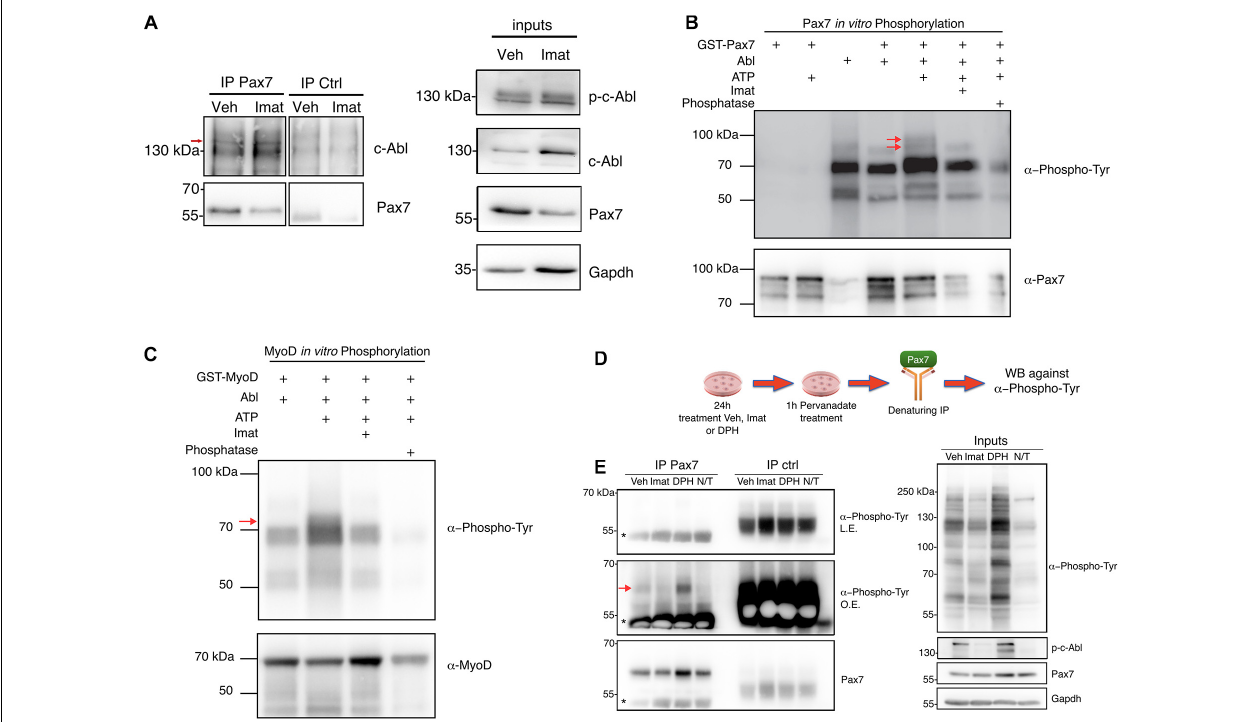
FIGURE 4 | c-Abl interacts and phosphorylates Pax7. (A) c-Abl co-immunoprecipitates with Pax7 in C2C12 cells. Cells maintained in PM were treated with vehicle (Veh) or 10 µ M Imatinib (Imat) for 24 h, followed by lysis and immunoprecipitation (IP) with anti-normal mouse IgG (IP ctrl) or anti-Pax7 (IP Pax7). c-Abl and Pax7 were detected by Western blot (Left panels). Red arrow shows the expected c-abl relative migration. Right panels show inputs for p-c-Abl, c-Abl, Pax7, and Gapdh ( n = 3). (B) Pax7 is phosphorylated by c-Abl. Recombinant c-Abl His-Tag and GST-Pax7 were incubated in kinase buffer as indicated, followed by WB for Phospho-Tyr and Pax7. Red arrows show Pax7 phosphorylated in tyrosine residues ( n = 3). As positive control, GST-MyoD was incubated with c-Abl, as is shown in (C) . Red arrow shows MyoD phosphorylated in tyrosine residues ( n = 3). (D,E) Pax7 is phosphorylated by c-Abl in C2C12 cells. The figure shows the following protocol to determine Pax7 phosphorylation in C2C12. Left panels show Pax7 IP followed by WB against Phospho-Tyr and Pax7 (L.E., less exposed membrane; O.E., overexposed membrane). Red arrow shows Pax7 phosphorylated in tyrosine residues and asterisk indicates IgG. Right panels show inputs for Phospho-Tyr, p-c-Abl, Pax7, and Gapdh ( n =